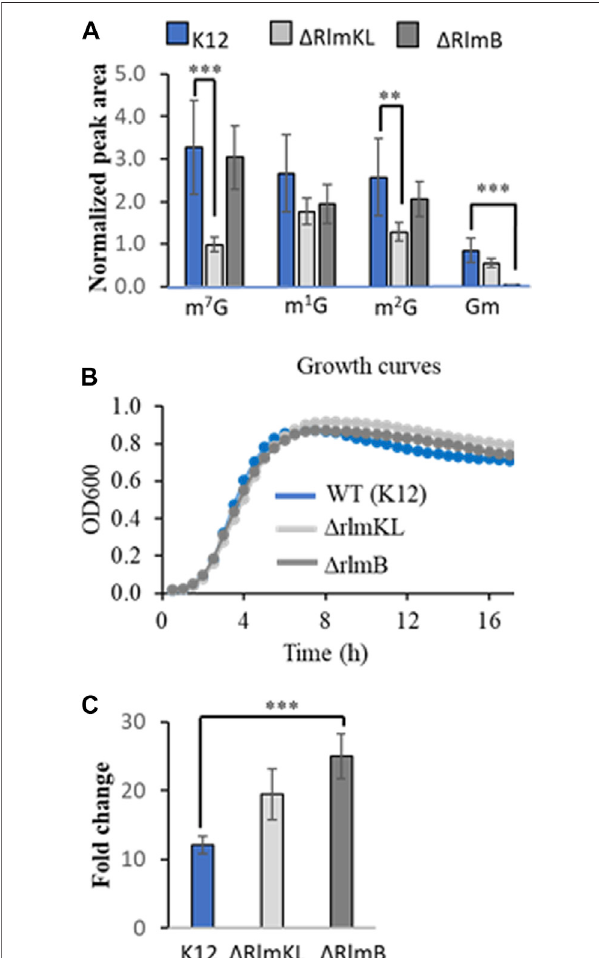
FIGURE4| Alteredlevels ofpost-transcriptional (enzymatic oroxidative) modi fi cations in rRNA isolated from ribosomes of K12 (wild Type), Δ RlmKL and Δ RlmB , E.coli strains. (A) Decreased levels ofguanosine methylations, 7- methylguanosine (m 7 G), 2-methylguanosine (m 2 G) and 2 ′ O- methylguanosine (Gm) in rRNA of E. coli strains de fi cient in respective methyltransferases. Peak area of each modi fi cation was normalized and plotted. Note the insigni fi cant changes in 1-methylguanosine (m 1 G) levels in these strains. (B) Identical growth behavior of three different strains of E. coli . C. Fold change of 8oxo-G in rRNA isolated from UVA-exposed ribosomes of E. coli strains. Datais shown as the mean ofthree biological replicate samples ± SD after normalization against internal standard 5 ′ bromo-2 ′ deoxycytidine. Statistical signi fi cance was computed using unpaired two-tailed t -test (*** p < 0.001, ** p <